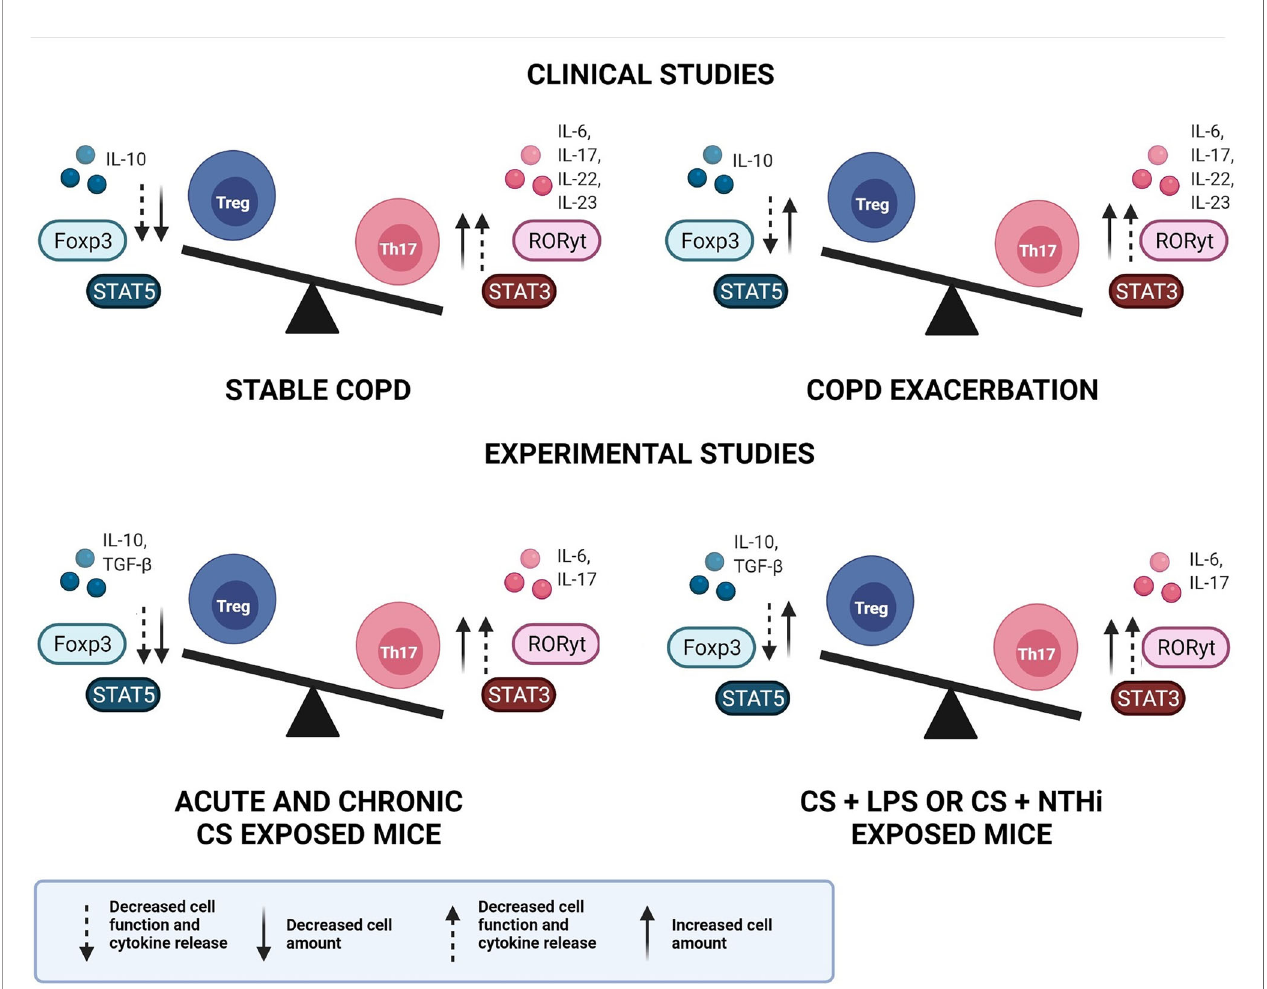
FIGURE 1 | Th17/Treg imbalance in COPD. Representative image of Th17/Treg imbalance in clinical and experimental studies, in both stable and exacerbated disease. An increase in both Th17 cell amount and function is observed in clinical and experimental studies, during stable and exacerbated disease. In contrast, the Treg response may present increased cell amounts, however with decreased function and cytokine release, leading to Th17/Treg imbalance. COPD, chronic obstructive pulmonary disease; Treg, regulatory T cell; Th17, T helper-17, IL, interleukin; Foxp3, Forkhead box p3; STAT, signal transducer and activator of transcription; ROR g t, retinoic acid orphan receptor; TGF- b , transforming growth factor- b ; CS, cigarette smoke; LPS, lipopolysaccharide; NTHi, Haemophilus in fl